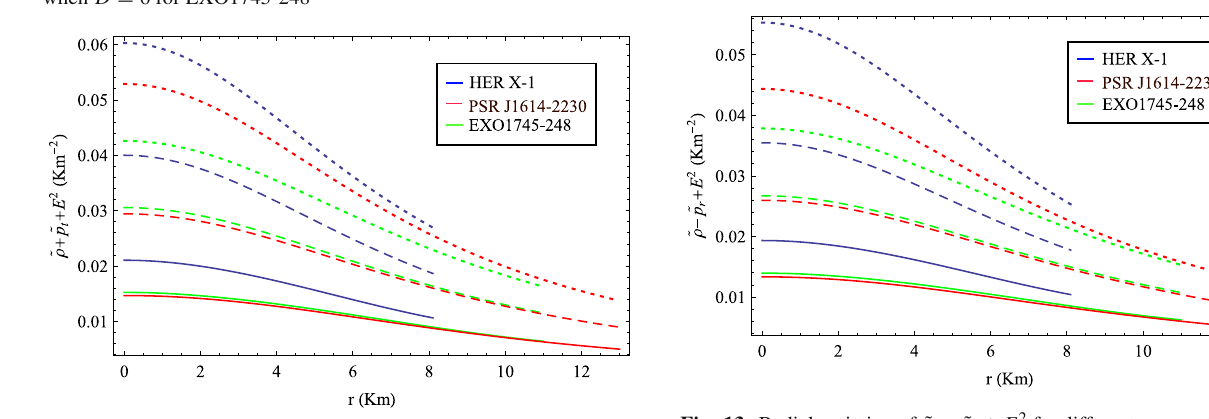
Fig. 11 Radial variation of ˜ ρ + ˜ p t + E 2 for different compact objects as indicated in the figure. Here plots with solid, dashed and dotted lines correspond to D = 4 , 5 and 6 respectively. To obtain the plots we choose (i) α = 0 . 4, γ = 0 . 45 when D = 4; α = 0 . 3, γ = 0 . 25 when D = 5 and α = 0 . 25, γ = 0 . 2 when D = 6 for HER X-1, (ii) α = 0 . 4, γ = 0 . 5 when D = 4; α = 0 . 3, γ = 0 . 25 when D = 5 and α = 0 . 2, γ = 0 . 15 when D = 6 for PSR J1614-2230, (iii) α = 0 . 4, γ = 0 . 5 when D = 4; α = 0 . 3, γ = 0 . 2 when D = 5 and α = 0 . 2, γ = 0 . 25 when D = 6 for EXO1745-248